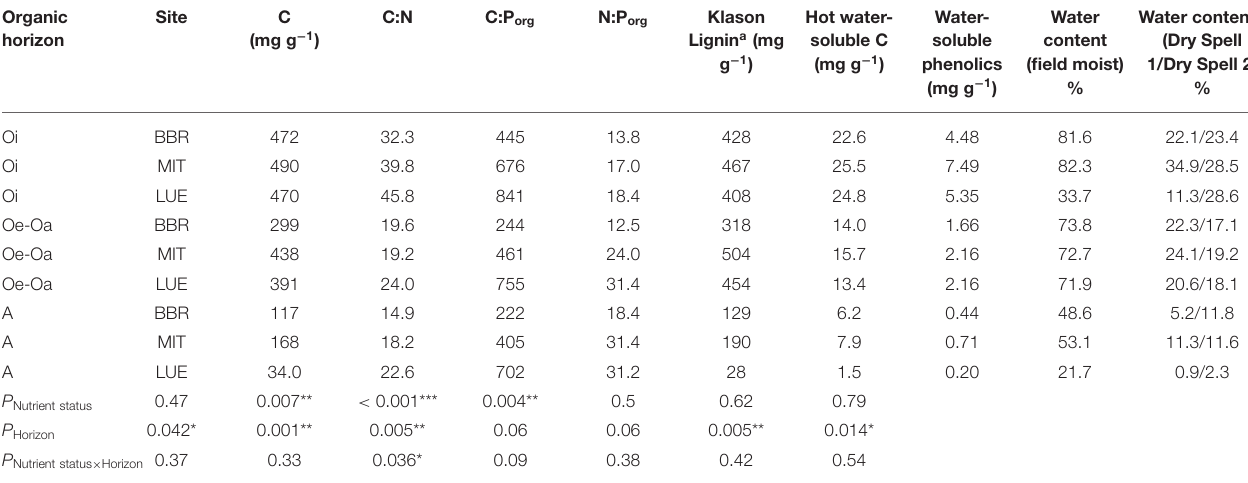
TABLE 2 | Selected chemical properties of the Oi, Oe-Oa, and A horizons of the beech forest sites Bad Brückenau (BBR), Mitterfels (MIT) and Lüss (LUE). Organic